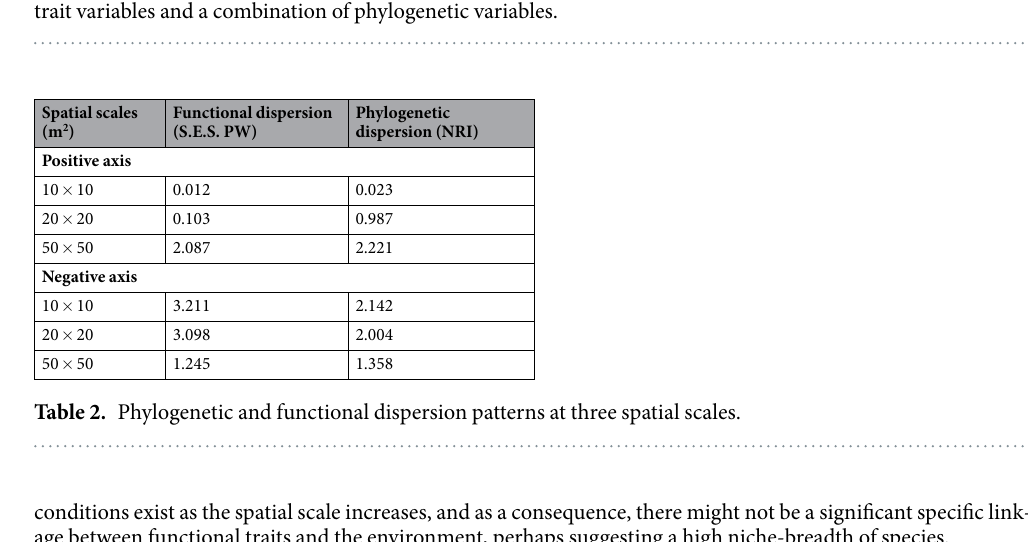
conditions exist as the spatial scale increases, and as a consequence, there might not be a significant specific link- age between functional traits and the environment, perhaps suggesting a high niche-breadth of species.